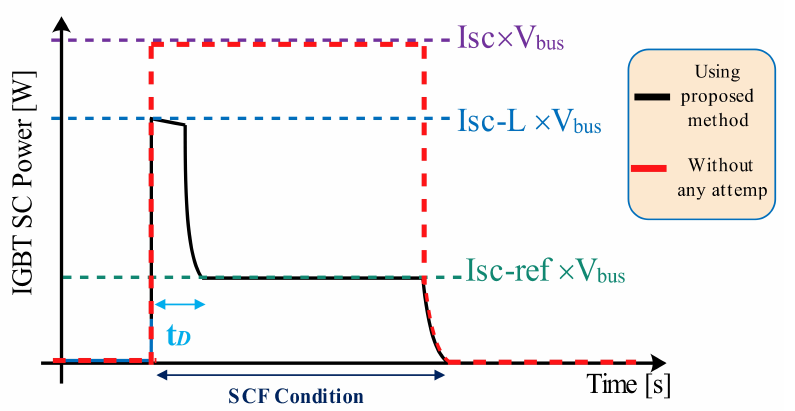
Figure 14. The SCF power using the proposed method and the case without any attempt to limit SCF current.